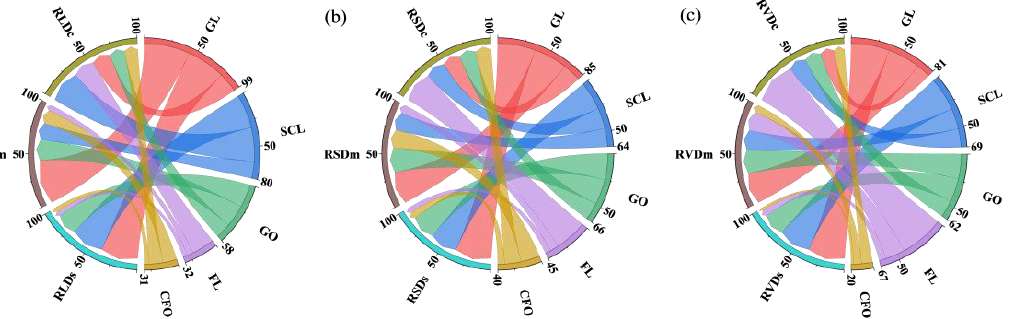
Figure 2. The percentage changes in different diameter classes for root length density ( a ), root surface area ( b ), and root volume ( c ) under different land use change. Notes: GL, grassland; SCL, farmland; GO, orchard with grass cover; FL, forest; CFO, orchard with no cover. RLDs, root length density of D ≤ 0.5 mm diameter class; RLDm, root length density of 0.5 mm < D ≤ 1 mm diameter class; RLDc, root length density of D ≤ 0.5 mm diameter class; RSDs, root surface area density of D ≤ 0.5 mm diameter class; RSDm, root surface area density of 0.5 mm < D ≤ 1 mm diameter class; RVDc, root surface area density of D ≤ 0.5 mm diameter class; RVDs, root volume density of D ≤ 0.5 mm diameter class; RLDm, root volume density of 0.5 mm < D ≤ 1 mm diameter class; RVDc, root volume density of D ≤ 0.5 mm diameter class.